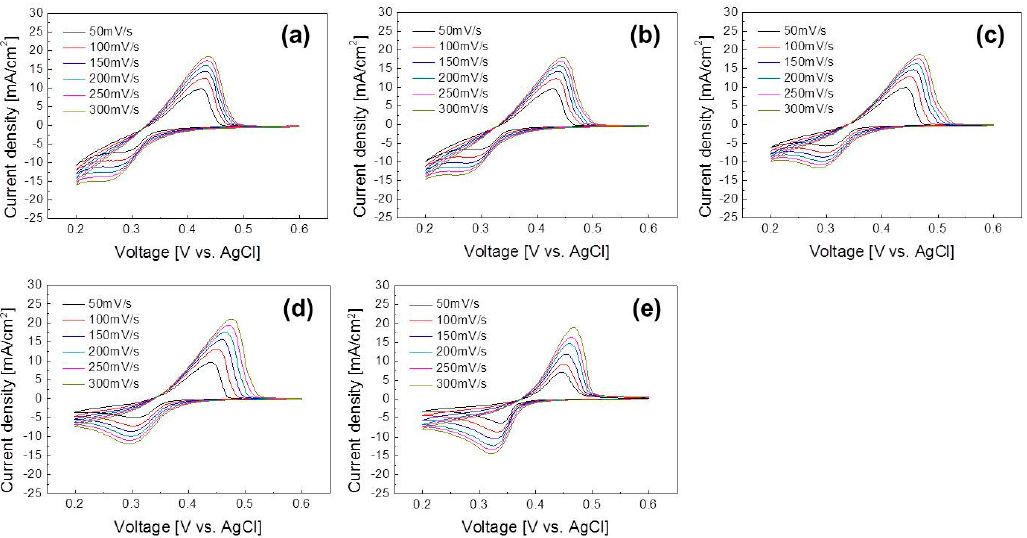
Figure 1. Cyclic voltammetry curves depending on the concentration of the added water: ( a ) 0 M, ( b ) 1.1 M, ( c ) 5.0 M, ( d ) 9.3 M, and ( e ) 20.8 M.